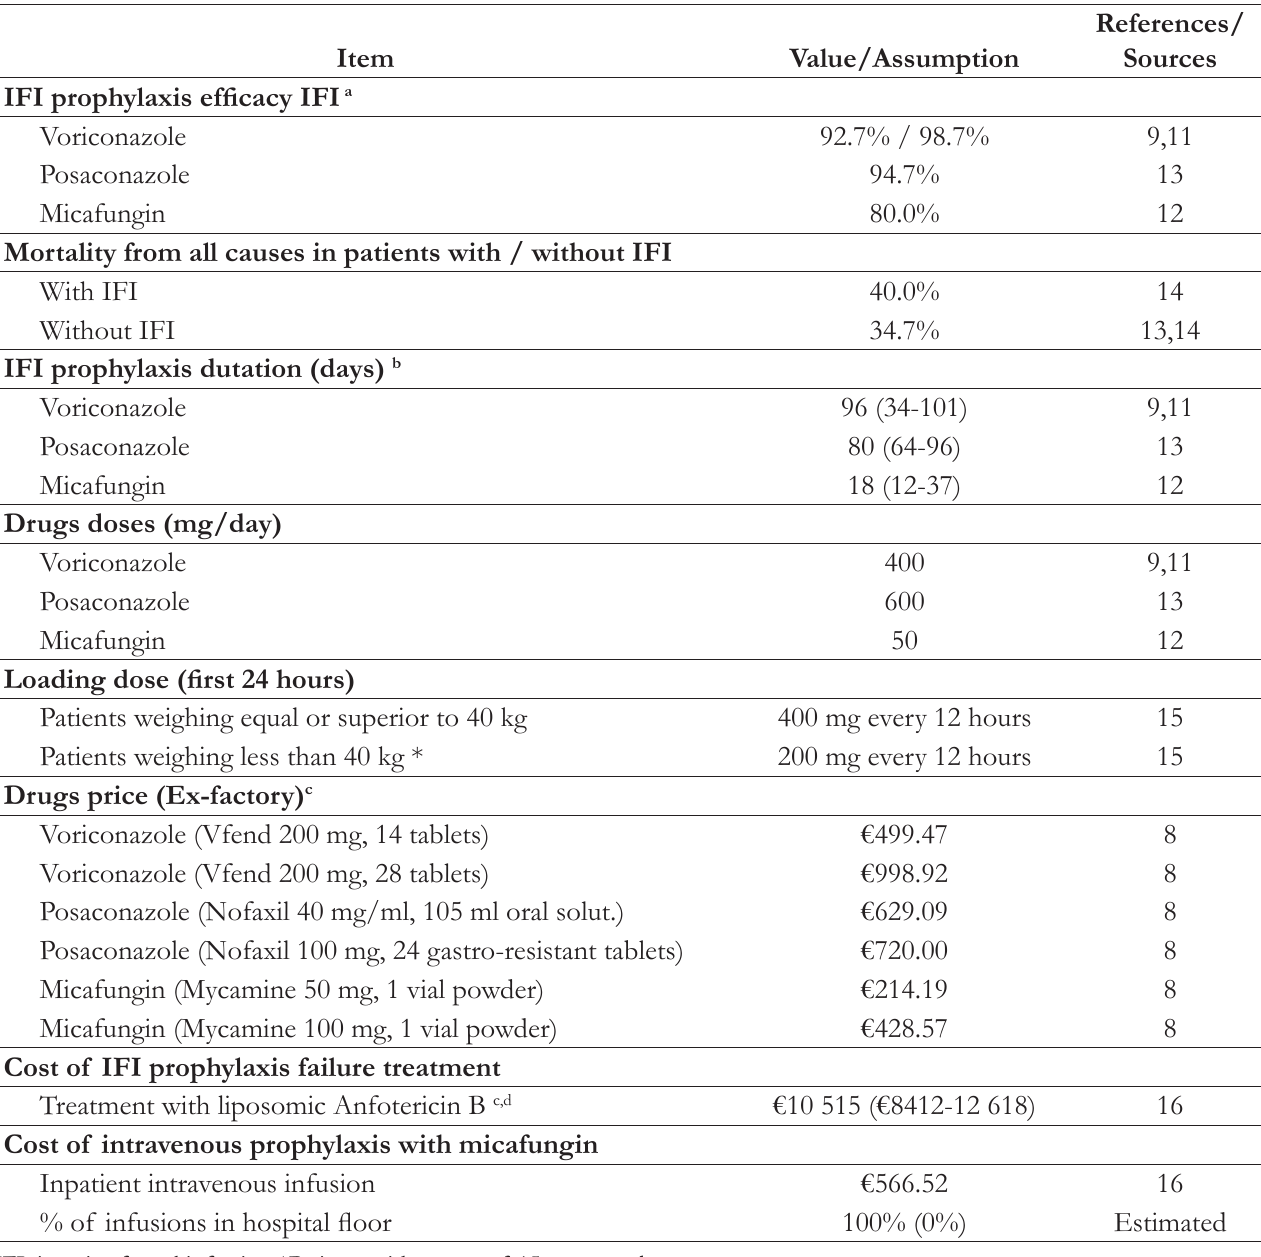
Table 1. Variables and Assumptions of the Economic